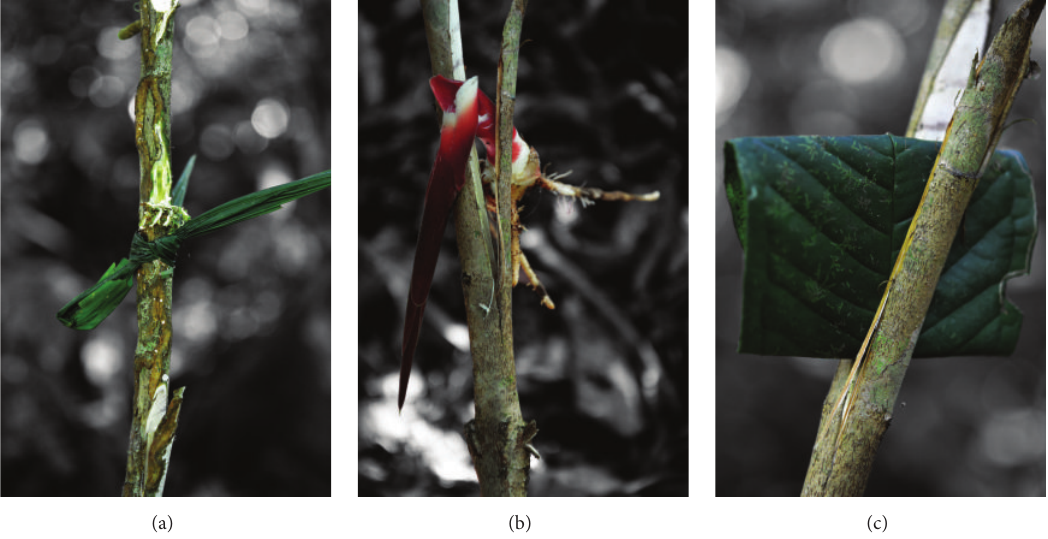
Figure 5: (a) I am badly injured. (b) Danger ahead. (c) I am